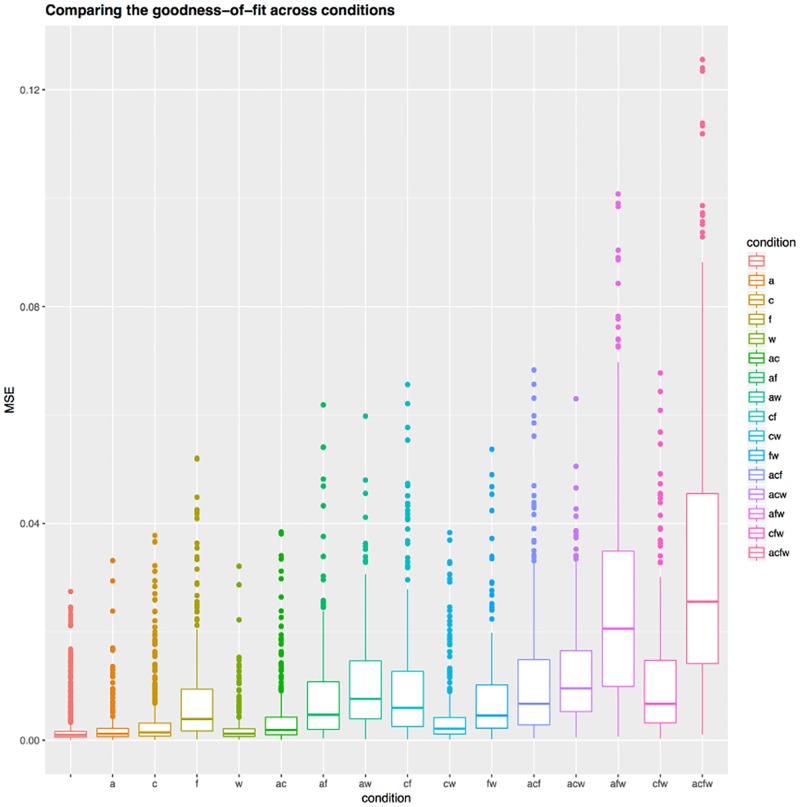
Comparing the goodness of fit across conditions.The distribution of goodness of fit (MSE) across conditions (identified both on the horizontal axis and by color) represented as boxplots.